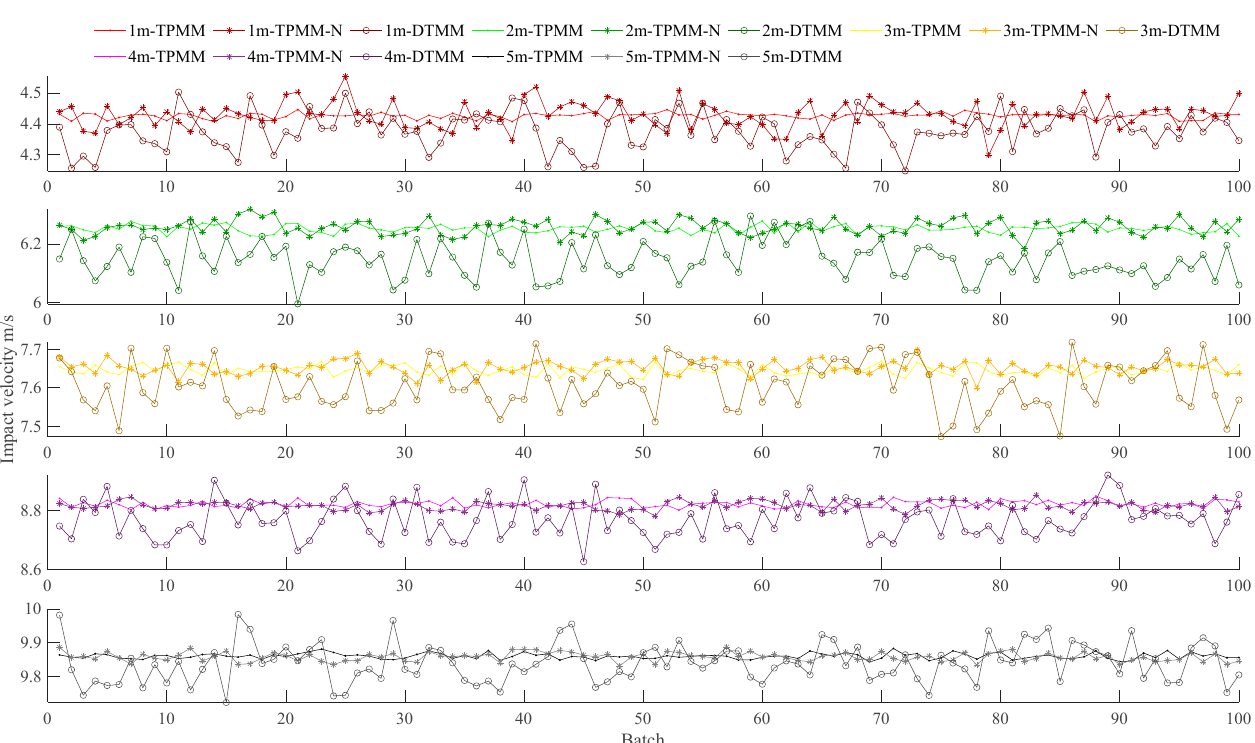
different. The measurement results are shown in Figure 6.